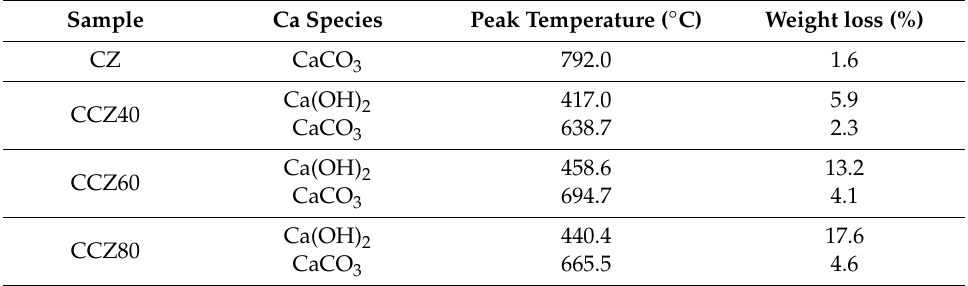
Figure 5. Thermogravimetric/differential thermal analysis (TG/DTA) curves of CaO–CaZrO 3 at different % of CaO. Table 2. Peak temperature (from differential scanning calorimetry (DSC)) and weight loss (from thermogravimetric analysis (TGA)) of the samples.